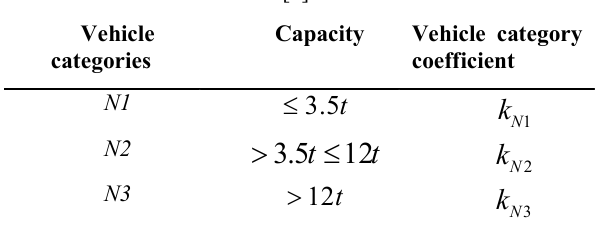
Table 1. Defining vehicle categories and coefficients [13], [4].